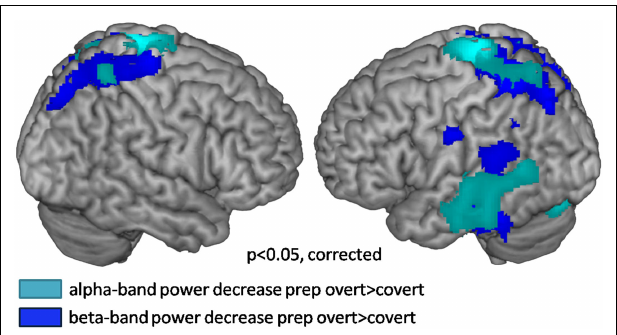
FIGURE 7 | Source localization of oscillatory power changes in the alpha and beta bands over 1s for the contrast preparation for overt vs. covert reading (cluster corrected p < 0.05). Cool colors represent power decreases.